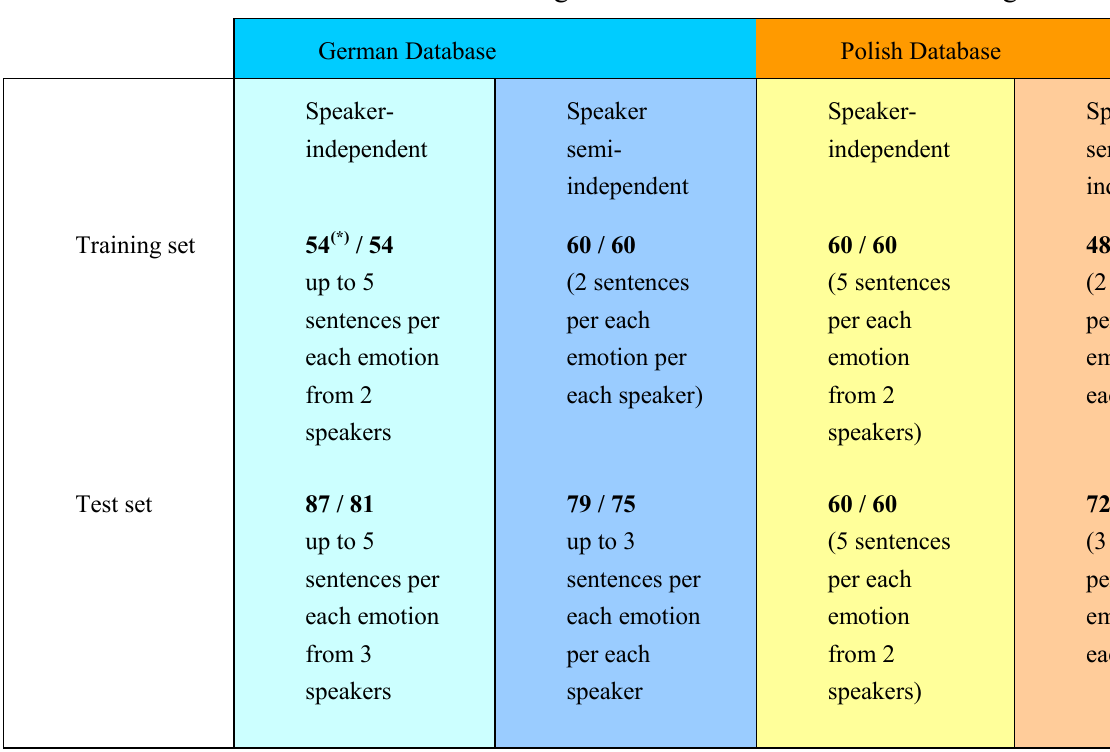
Table 2. A size of training and test sets used in emotion